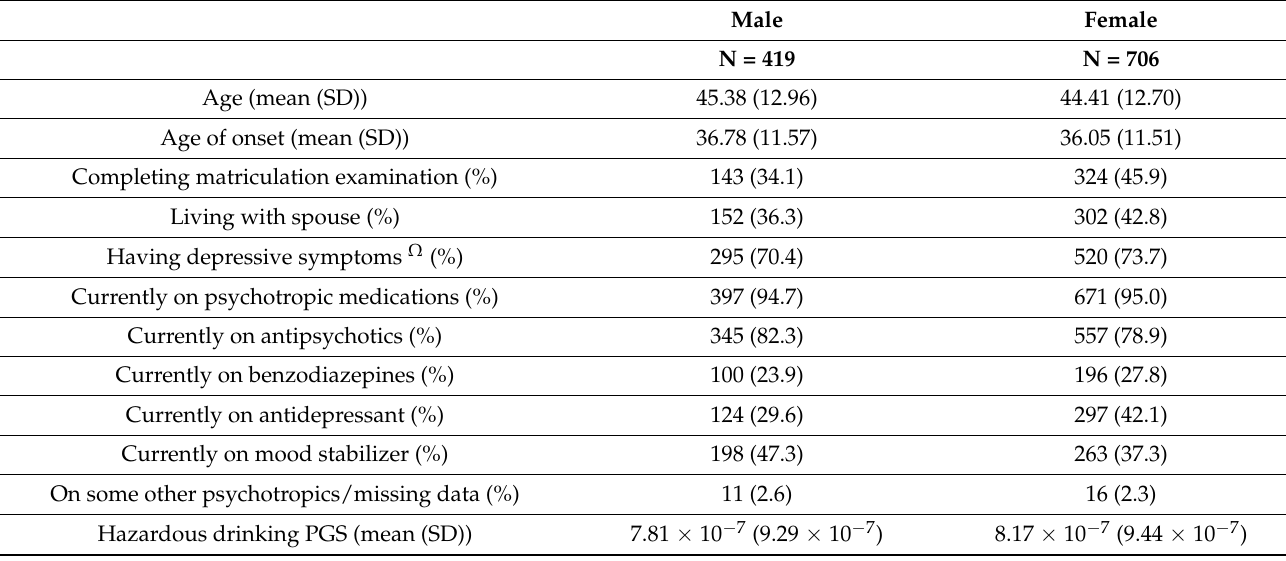
Table 3. Background factors and hazardous drinking PGS in male and female bipolar disorder